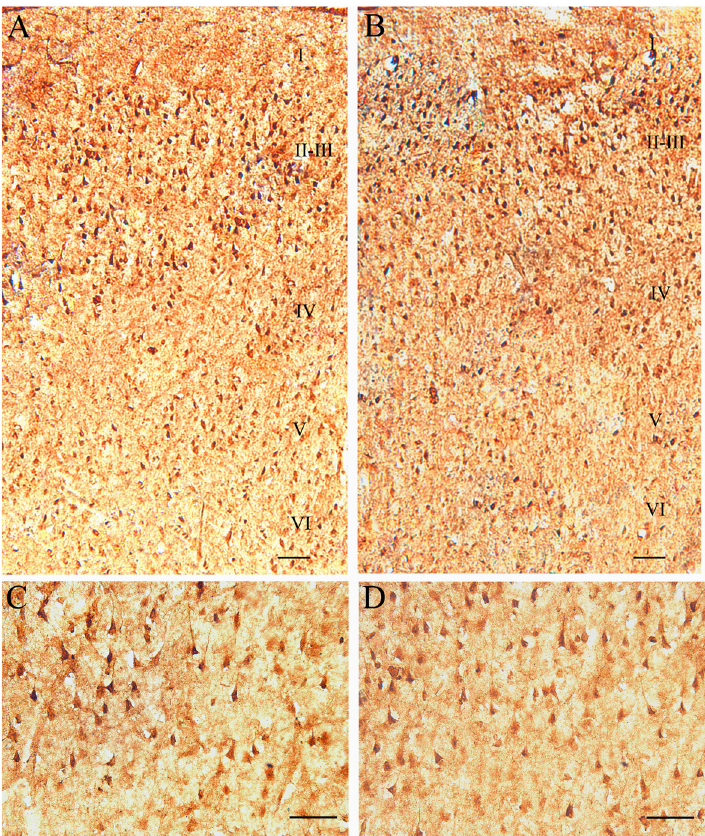
Fig 6. Immunohistochemical labeling of GABAergic neurons in the primary visual cortex of DR cats (A&C) and normal control cats (B&D). (A&B) show the distribution of GABA neurons across different cortical layers (layer I, II-III, IV, V and VI) at a low amplification. (C&D) show GABA neurons at a higher amplification. The scale bar equals to 25 μ m.